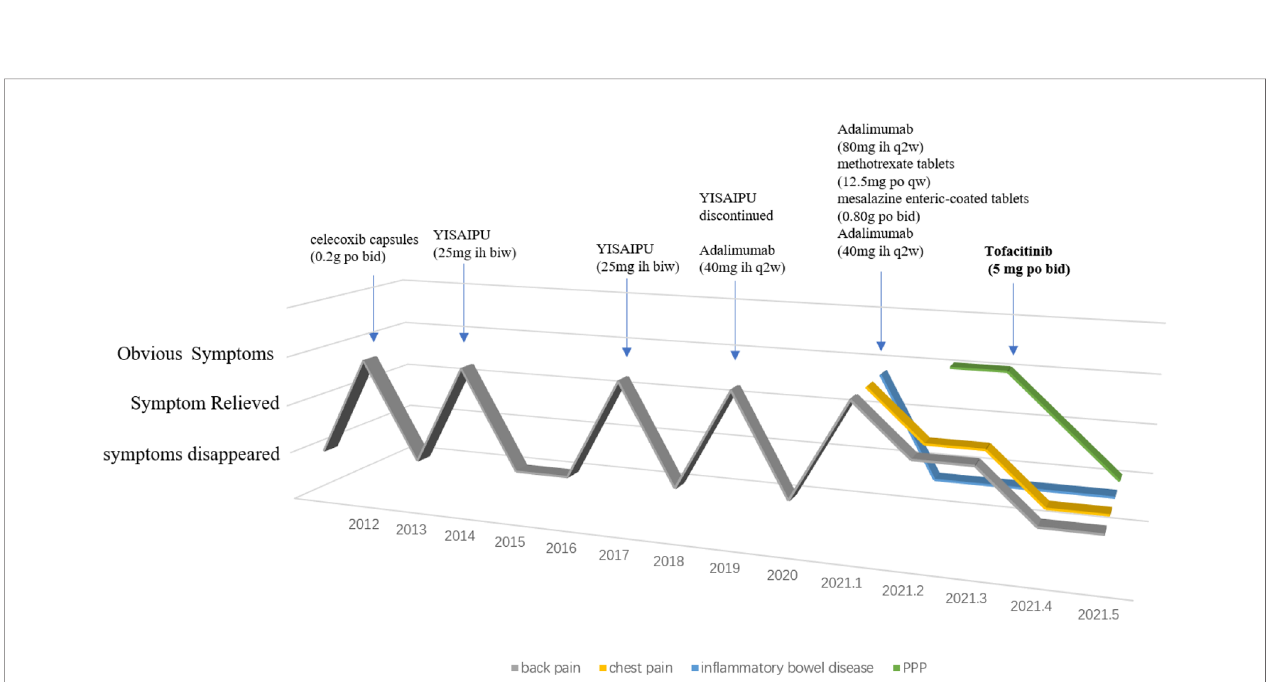
FIGURE 2 | Treatment options and outcomes for patients from 2012 to 2021.